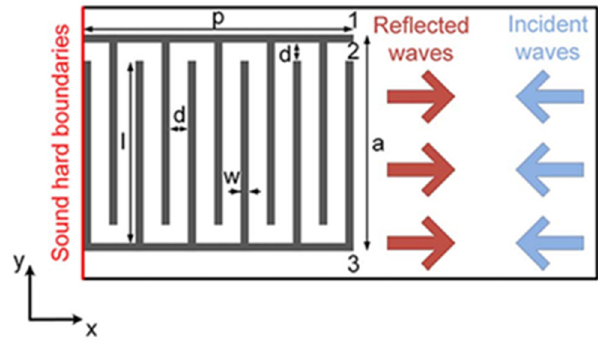
Figure 6 . A 2D coiled structure acoustic metasurface [82]. Figure 6. A 2D coiled structure acoustic metasurface [82].